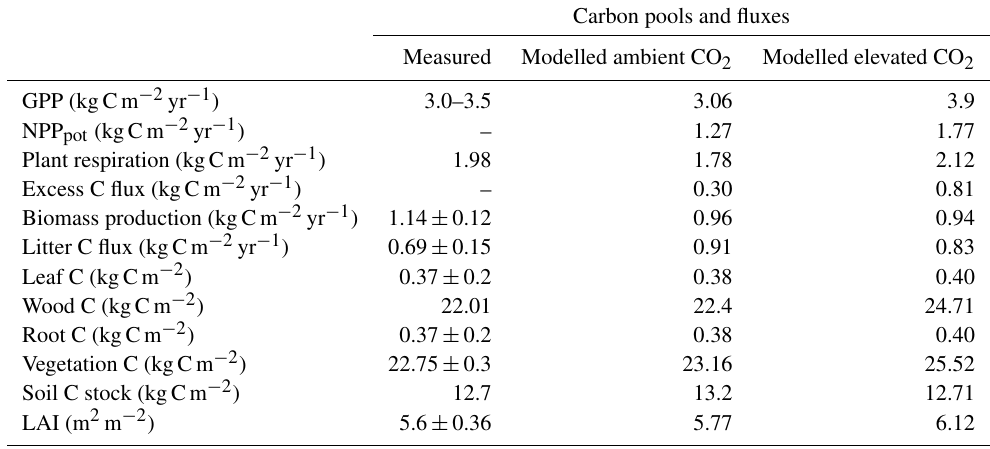
Carbon pools and